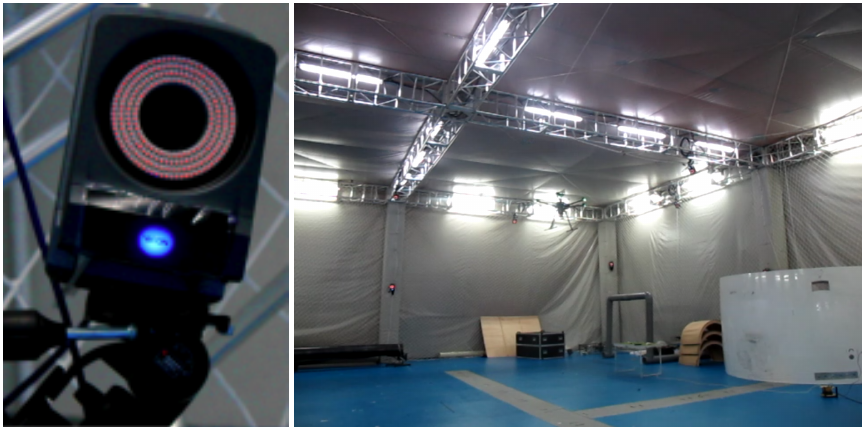
Figure 4. Vicon camera ( left ) and CATEC indoor testbed ( right